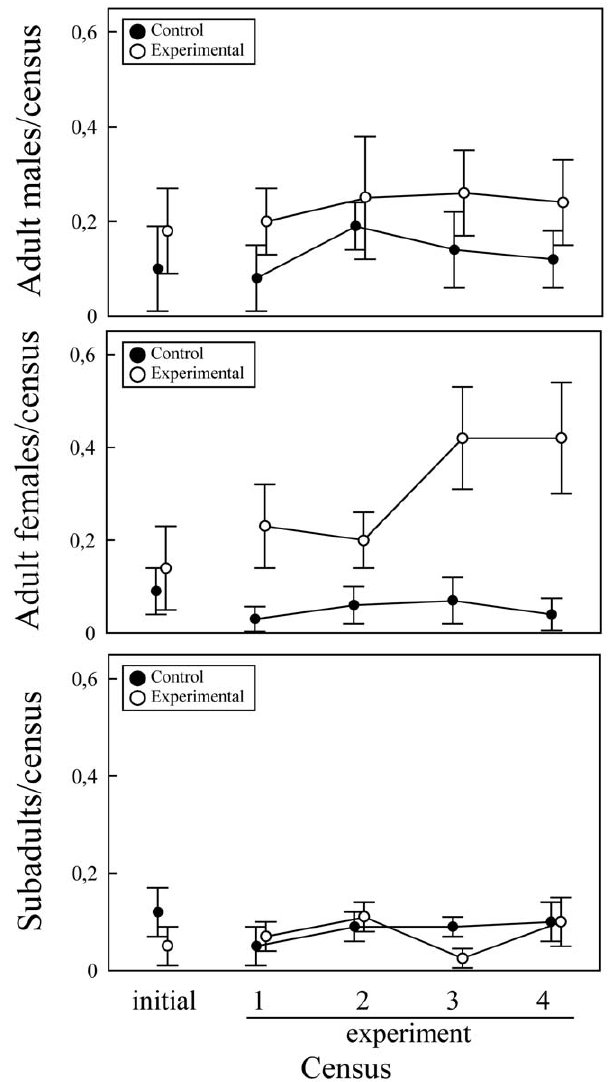
Figure 1. Effects of scent manipulation on lizard density. Mean 6 SE number of (a) adult males, (b) adult females or (c) subadult lizards observed in each census of the control (black circles) and experimental (open circles) plots before the experiment (initial) and during the four days after rocks were supplemented with ergosterol (experimental) or a control solution.